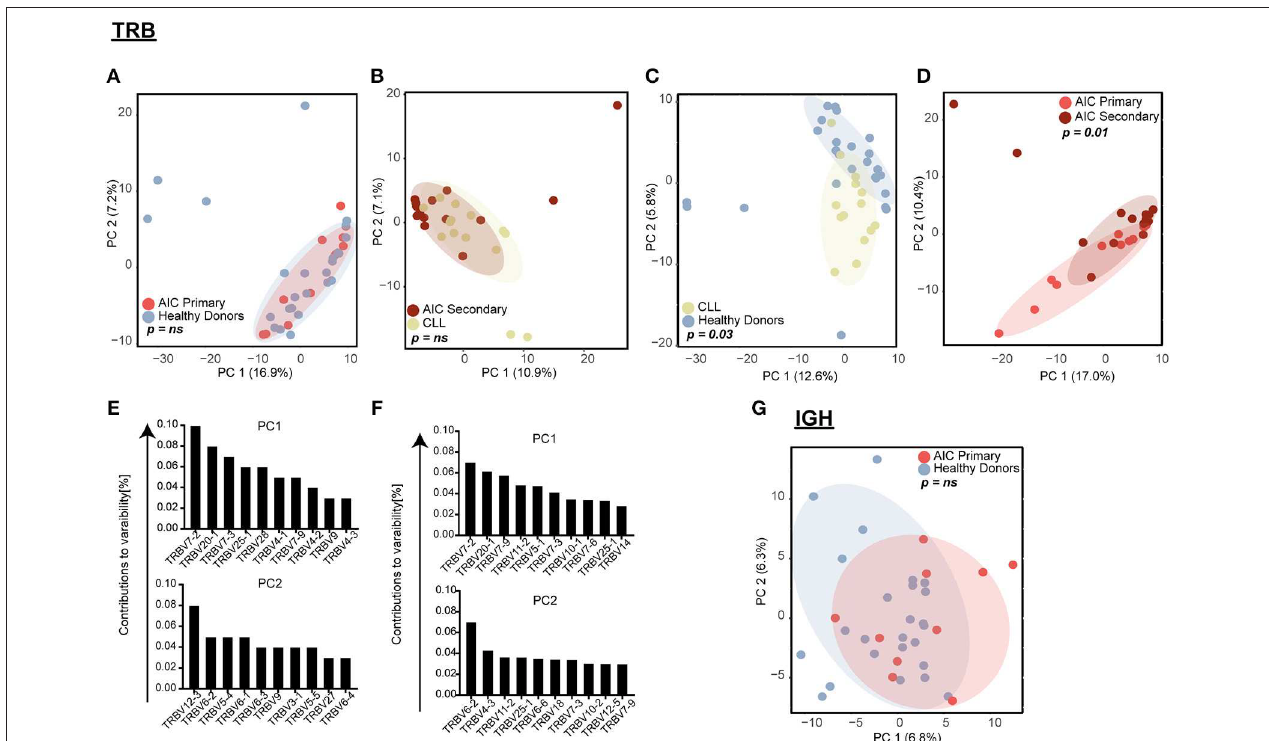
FIGURE 2 | Principal component analysis (PCA) of VJ gene usage. TRB VJ PCA of (A) primary AIC vs. HD, (B) secondary AIC vs. CLL, (C) HD vs. CLL, and (D) primary vs. secondary AIC. Ten highest contributing variables for PCA of HD vs. CLL (E) and primary vs. secondary AIC (F) for each principal component in descending order are shown. (G) IGH VJ PCA for primary AIC vs. HD. Statistical analysis: Pillai–Bartlett test of MANOVA of principal components 1 and 2. AIC, Autoimmune Cytopenia; IGHV , Immunoglobulin heavy-chain V gene; CLL, Chronic Lymphocytic Leukemia; PC, Principal Component; TRBV , T cell receptor beta V